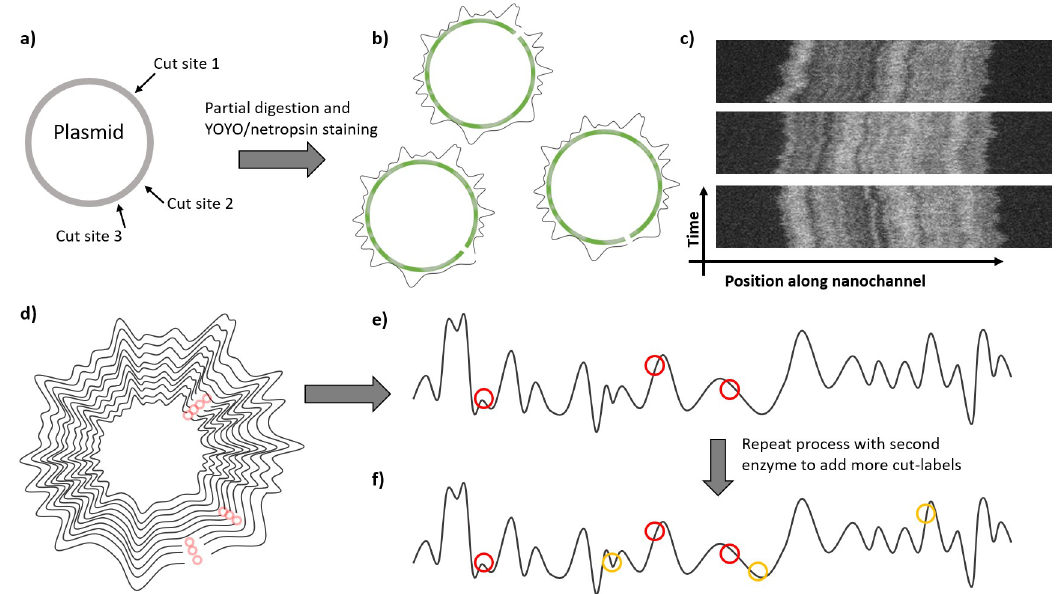
Fig 1. Generating dually labeled DNA barcodes using partial plasmid enzyme digestion and competitive binding labeling. a) Plasmid with three theoretical cut sites for a restriction enzyme. b) After the plasmid is partially digested and stained with YOYO/ netropsin, we get three sub-populations with cuts at one of the three sites. Here green circles depict YOYO/netropsin stained plasmids and black circular curves around plasmids depict the fluorescent intensity profile. The discontinuity depicts enzyme cut on the plasmid. c) Shows representative experimental kymographs of three sub-populations when 130 kb plasmid was digested with the AscI enzyme. d) After imaging many molecules, their intensity profiles can be aligned to create a circular consensus plot. Here we see a circular consensus plot with three cut sites marked with red circles. e) A consensus intensity profile can then be obtained and cut-labels can be placed on it to generate a dually-labeled barcode. f) Potentially, the process can be repeated with another set of enzymes in order to add more cut-labels to the